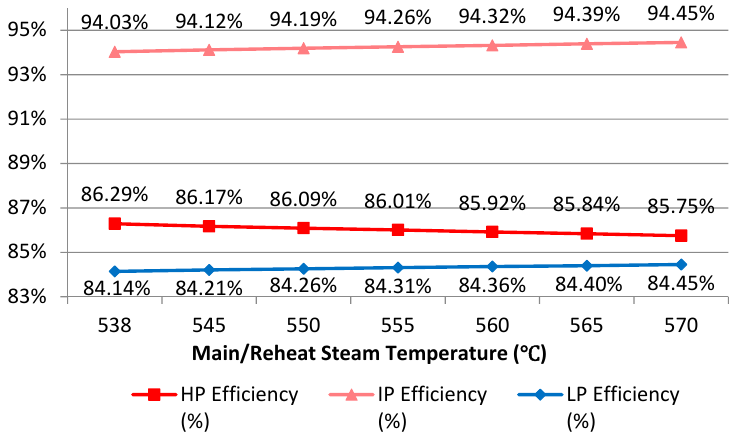
Figure 9. Effect of the main steam temperature on turbine stage efficiency.